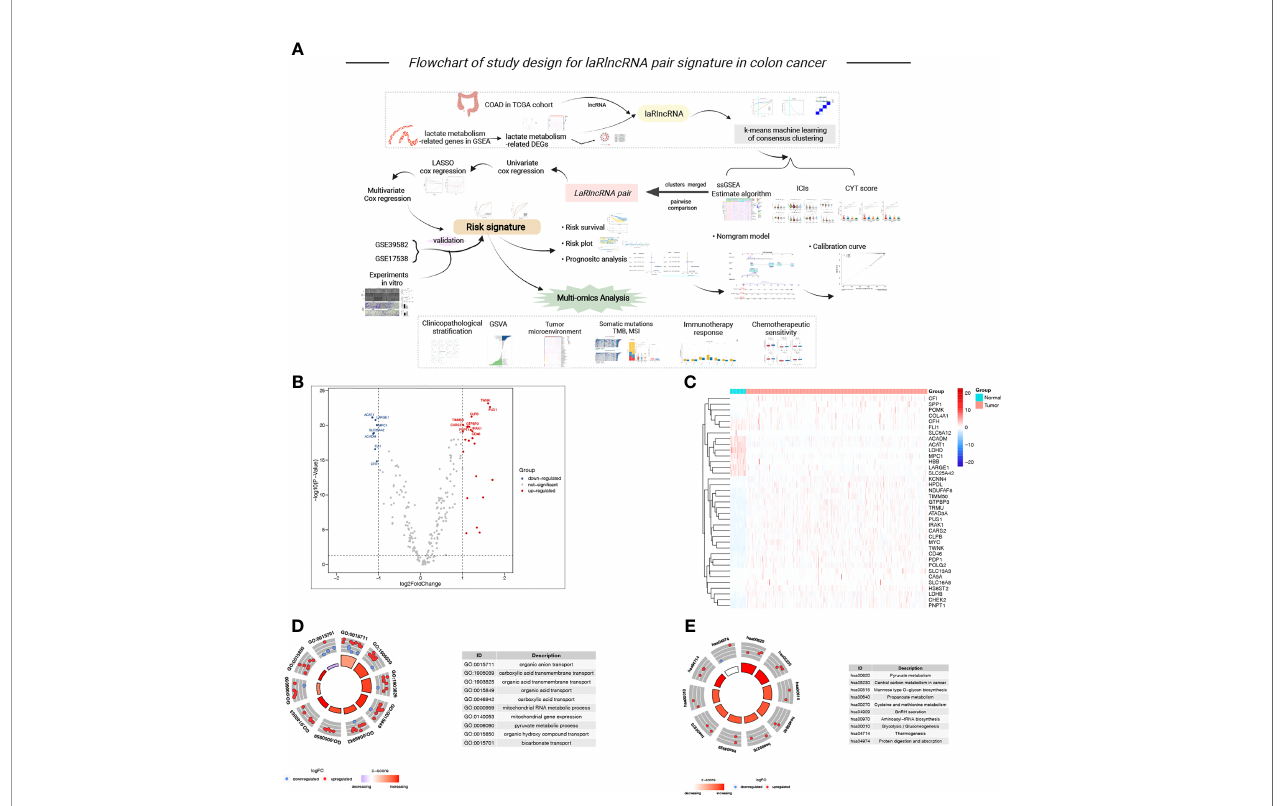
FIGURE 1 | (A) Flowchart of our study, (B, C) The volcano plot and heatmap of lactate metabolism-related DEGs between tumor and normal samples, (D, E) The GO and KEGG circle plot of functional enrichment